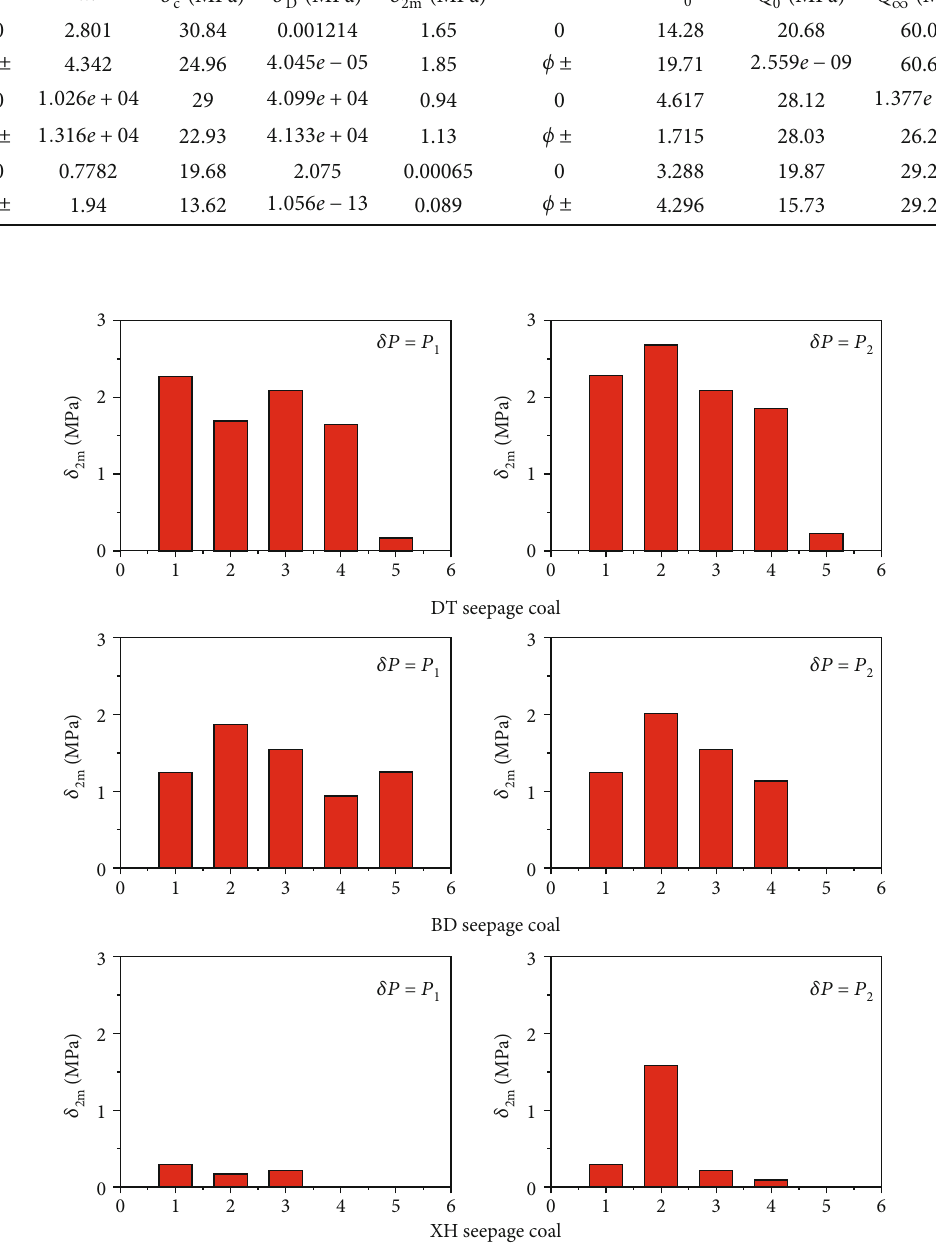
Figure 7: Mean fi tting deviations of strength criteria for seepage coal